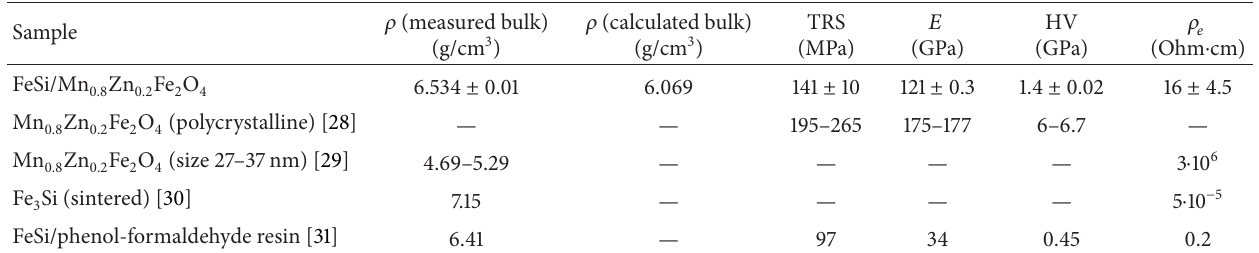
Zn Fe O . The columns determine the measured and calculated 0.8 0.2 2 4